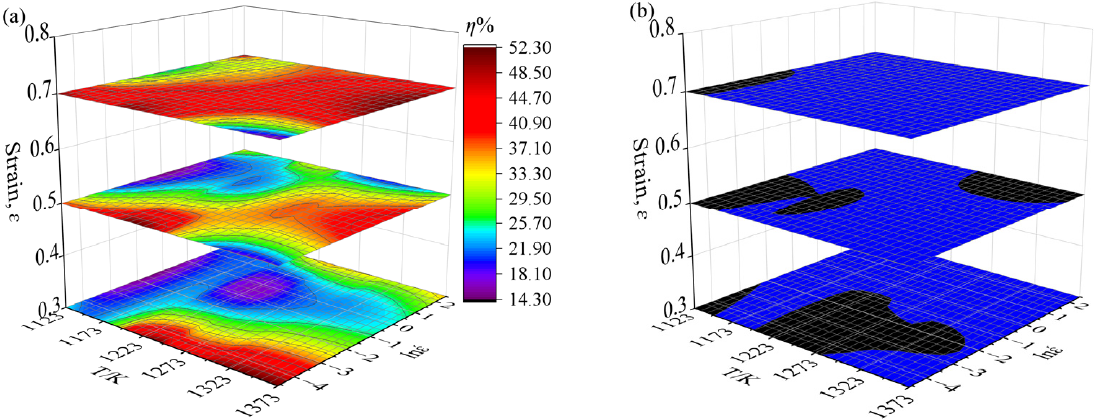
Figure 13. ( a ) Power dissipation maps of Q345 under the different strain; ( b ) Instability diagram of Q345 under the different strain.